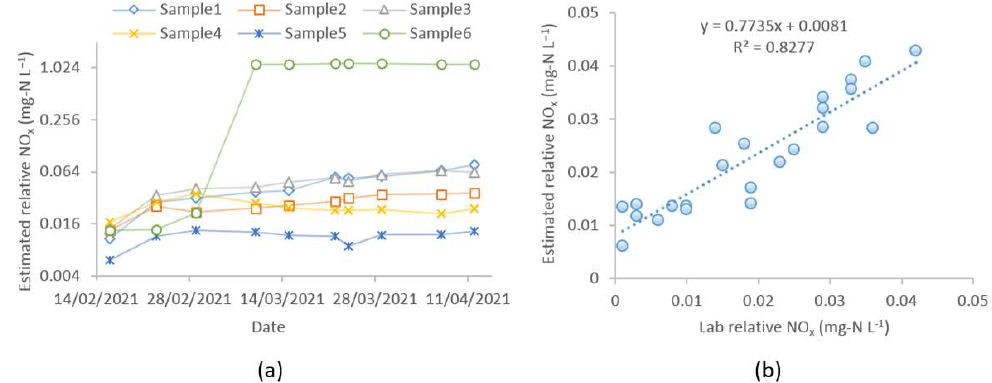
Figure 9. ( a ) Estimated relative NO (cid:2934) − concentration (mg-N L −1 ) by the proposed method; ( b ) linear relationship between the estimated and the lab data (the data point in Sample6 after nitrification occurrence was not included in the plot, considering the fact that it has a relatively higher NO (cid:2934) − value, which can affect the trend